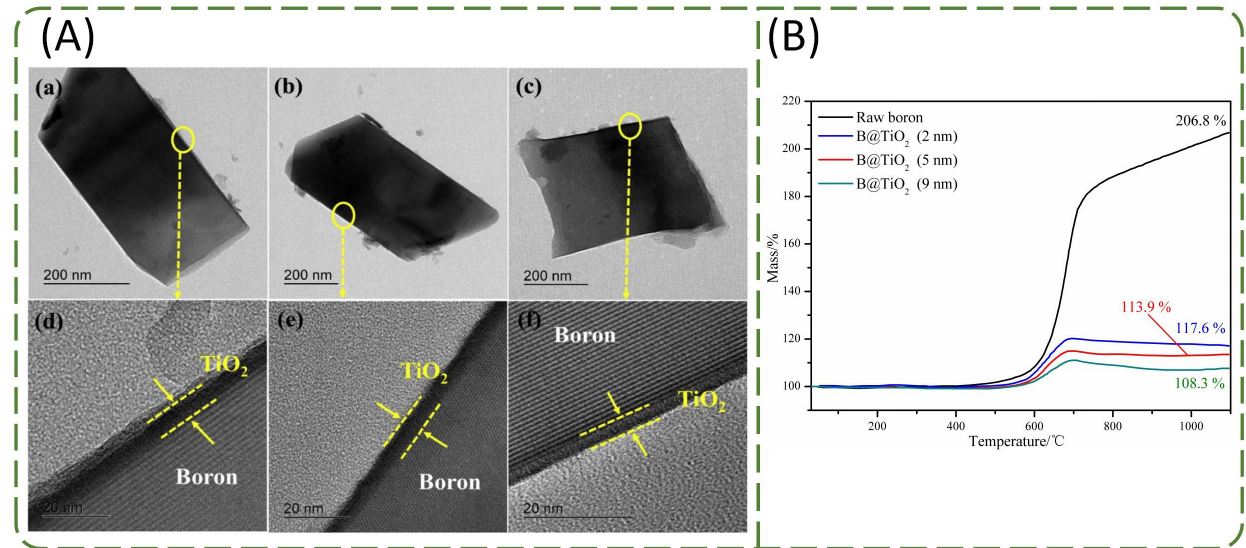
Figure 18. ( A ) TEM images of B@TiO 2 in ( a , b , c ) low and ( d , e , f ) high resolution; ( B ) TGA curves of raw boron and B@TiO 2 [117].